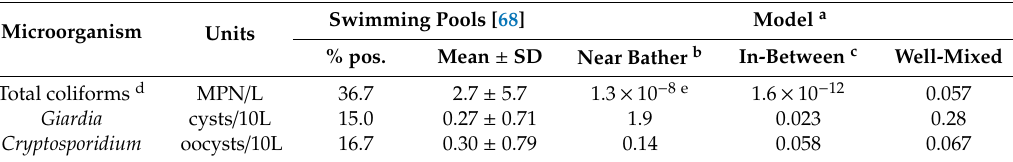
Table 8. Model comparison to swimming